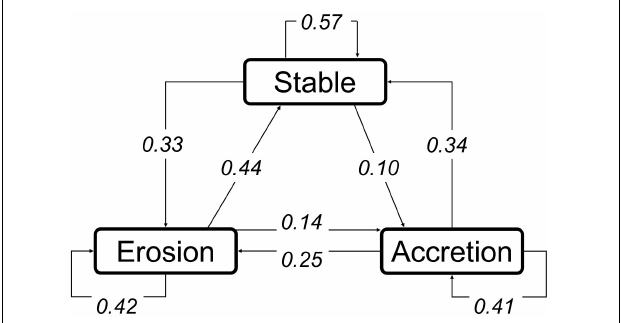
FIGURE 2 | Example of discrete-time Markov chain representing the coastal states and their transition probabilities for the 6661 sites of Table 1 . The graphic reads as follows: coastal sites in erosion in the 1980s have a probability of 0.42 to be still in erosion in the 1990s, 0.14 to be in accretion and 0.44 to be s.